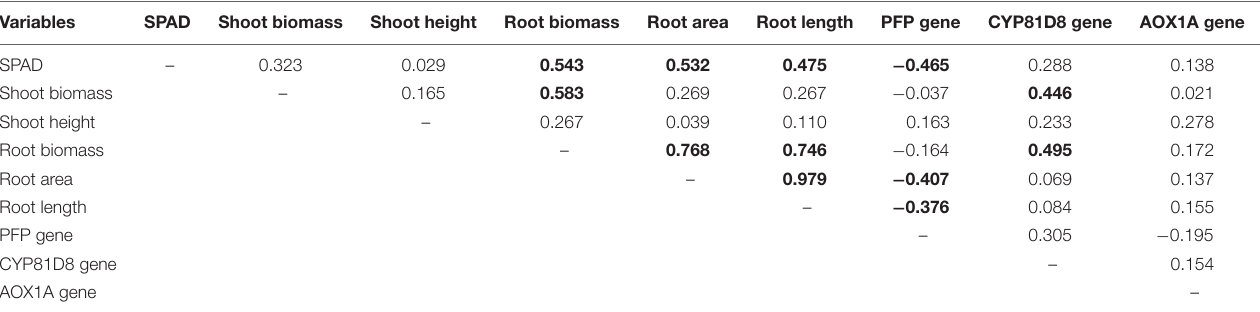
FIGURE 7 | Principal component analysis (PCA; top right) with highly informative variables (loadings > | 0.3| ) in bold within synthetic variables F1 and F2 (bottom right Table); and multigroup discriminant analysis (MDA; top left) in waterlogged (W) and control (C) plants of 10 representative hybrids and the inbred line B73 at 17 DAS. TABLE 1 | Correlation coefficients (r) among the differences (control – waterlogged) for morphological and gene expression variables, with significant correlations in bold ( P ≤ 0.05).